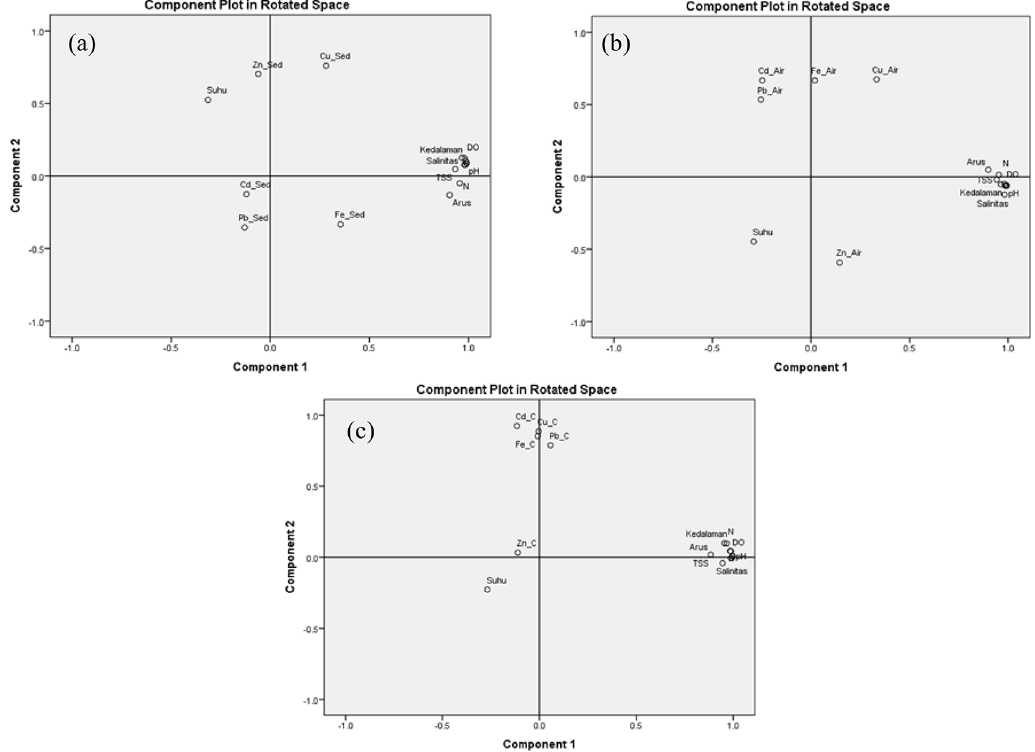
Figure 6. PCa of heavy metal (µg/g) of Cd, Pb, Cu, Fe, and Zn and Water Parameters during Northerly Westerly monsoon in Bintan Island (a: in Caulerpa), (b: in the water), and (c: in